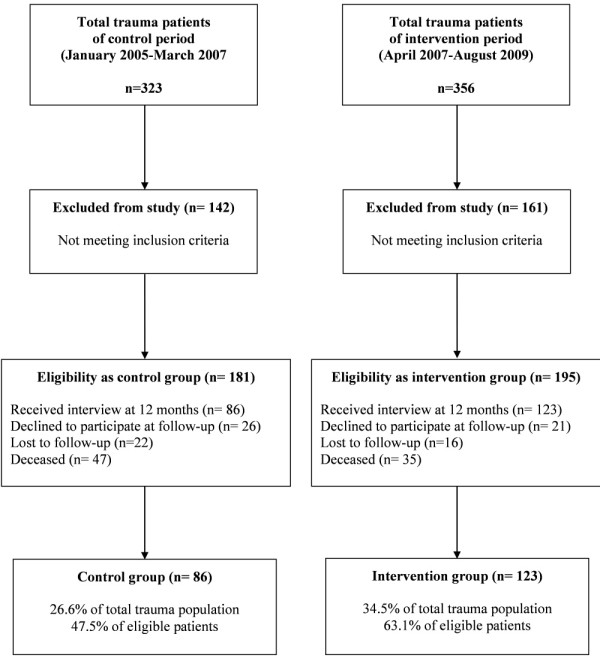
Flow diagram of the study.